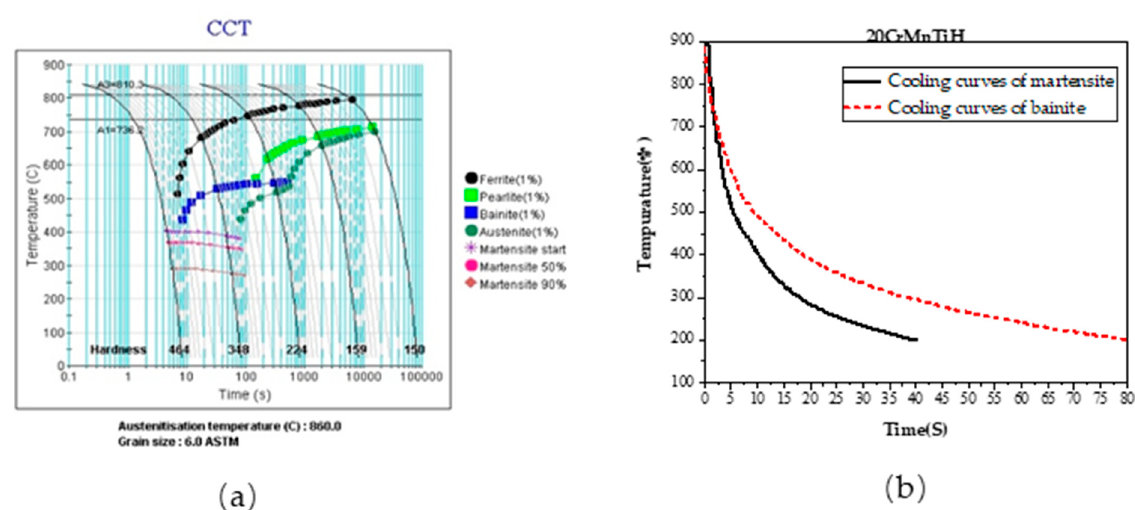
Figure 5. CCT curves and cooling curves of 20CrMnTiH steel. ( a ) CCT curves of 20CrMnTiH steel; ( b ) cooling curves of 20CrMnTiH steel when martensitic and bainitic transformations can be obtained.